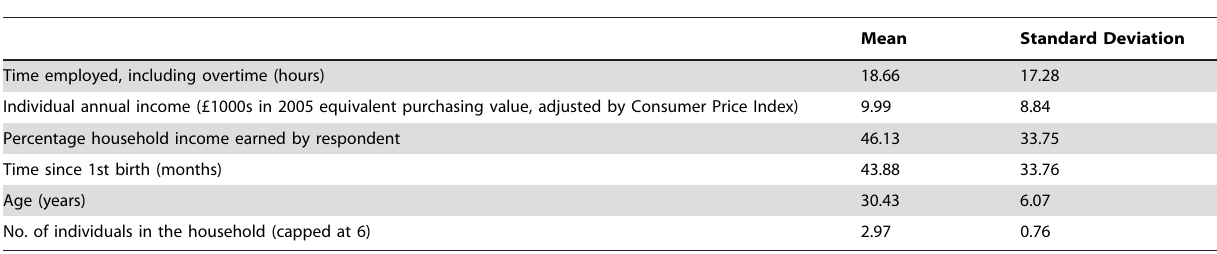
Table 3. Descriptive statistics of continuous